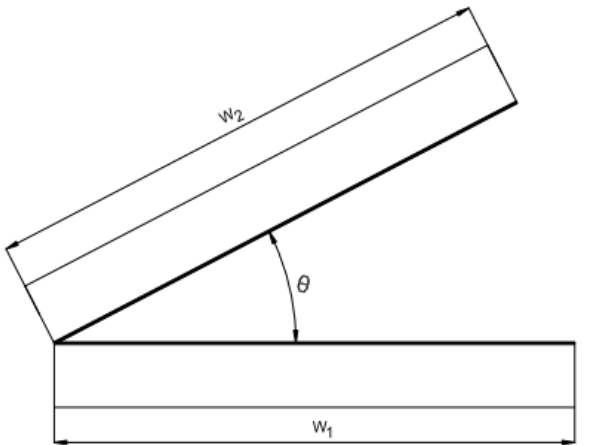
Figure 16. Absorbed radiation of the third-stage radiation baffle versus α.